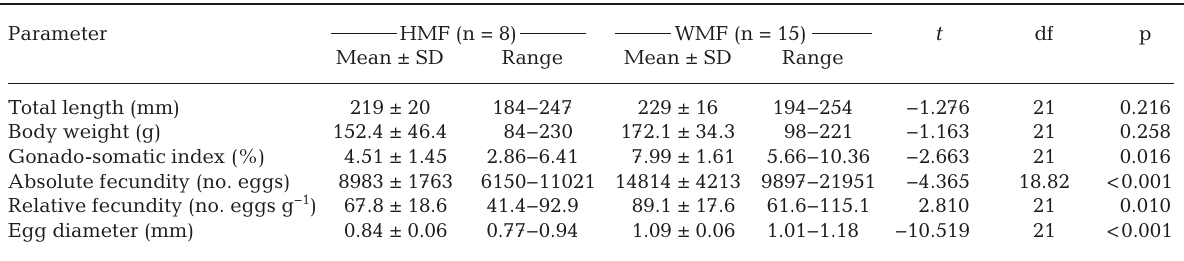
Table 5. Reproductive characteristics of age 1+ hatchery-reared mandarin fish (HMF) and wild mandarin fish (WMF) in Xiaosihai Lake, and test